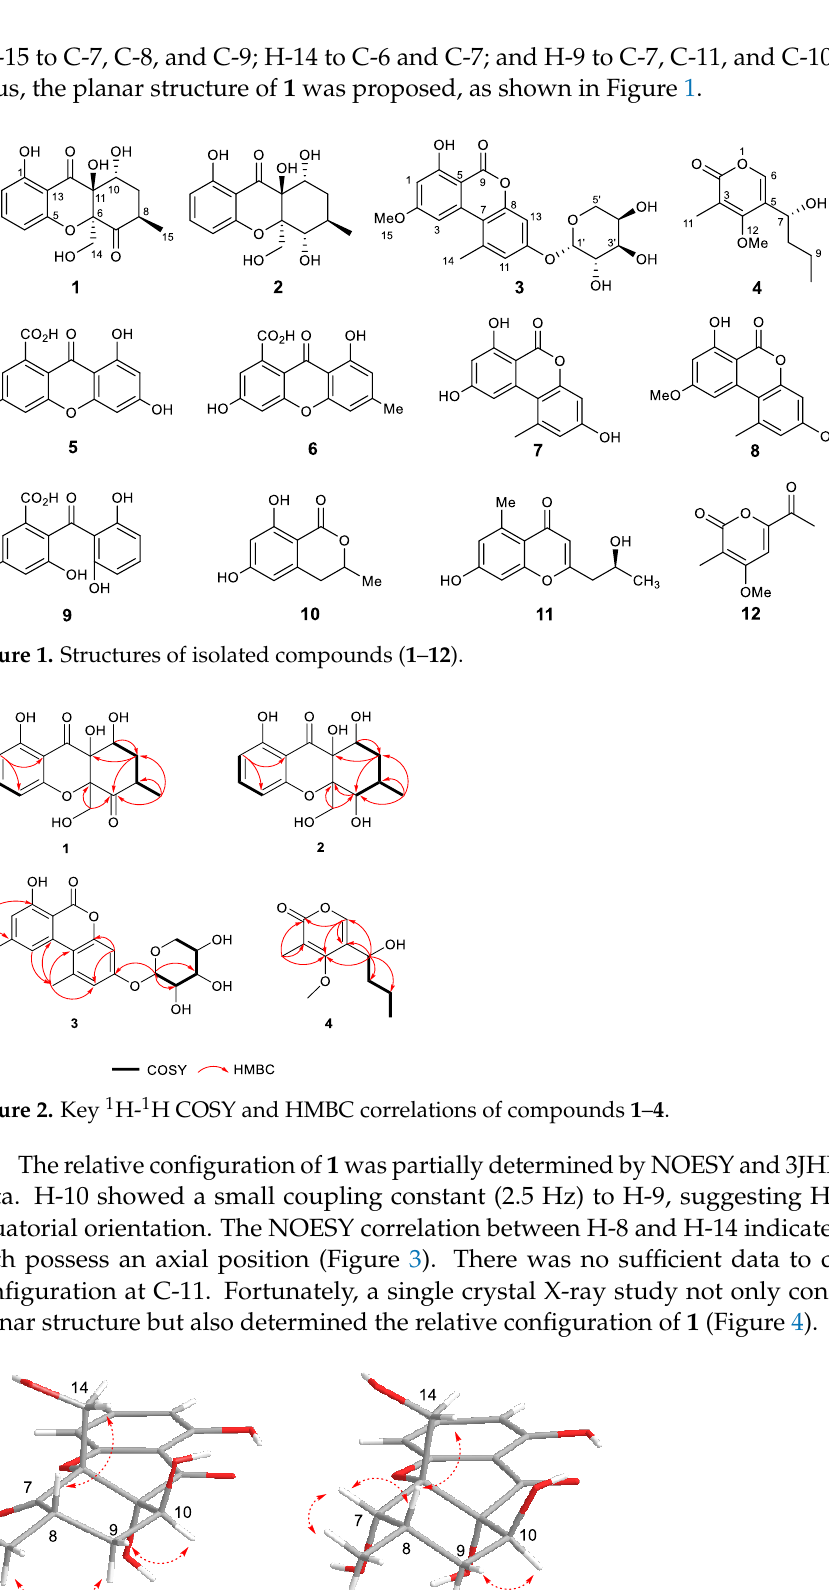
Figure 3. Key NOESY correlations of 1 and 2 .